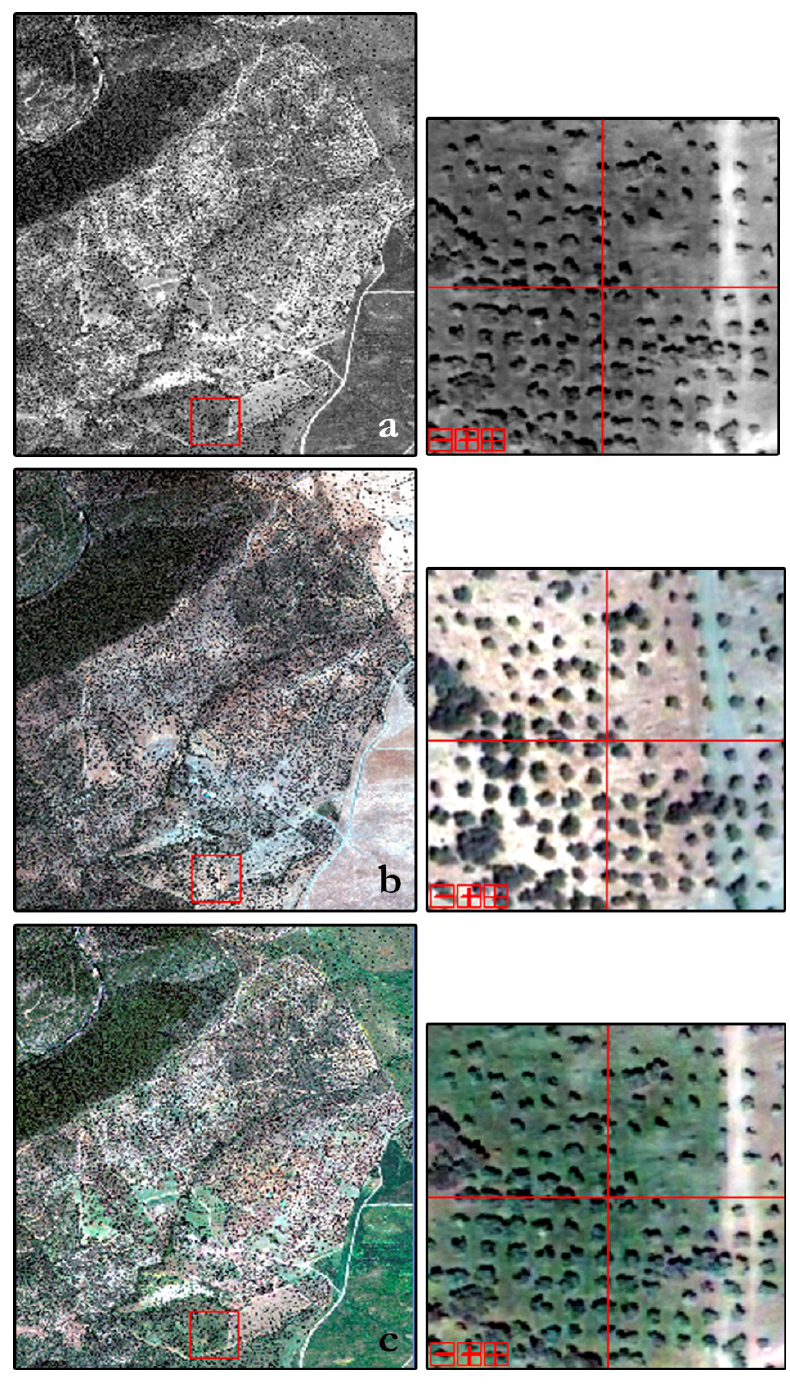
Figure 1. Images acquired by QuickBird 2. ( a ) Panchromatic image from May 2009 (0.6 m); ( b ) Multispectral images from July 2008 (2.4 m); and ( c ) Multispectral images from May 2009 (2.4 m).